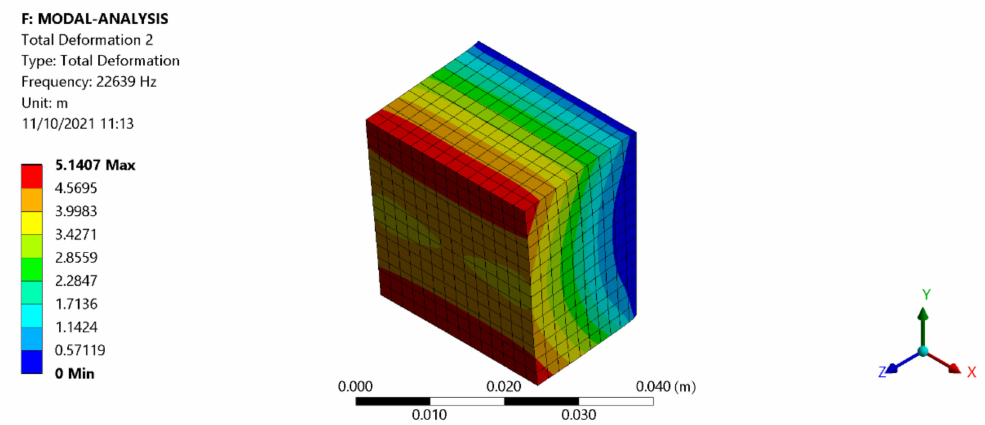
Figure 13. The second modal shape of the pair.